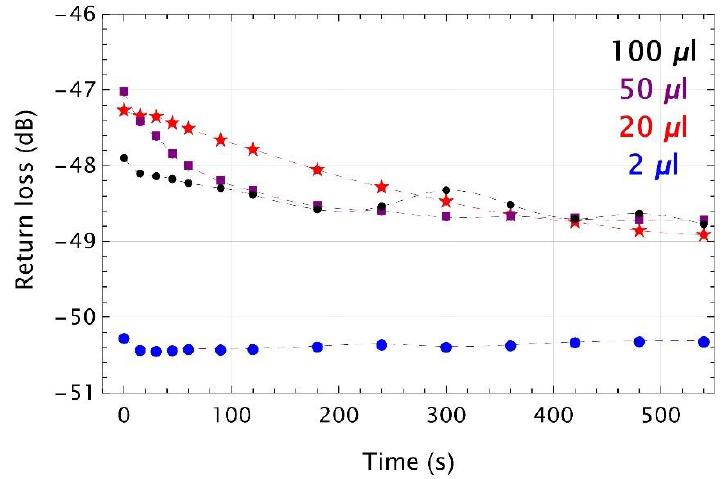
Figure 5. Time responses as return loss vs. time for MMF 105 without microtip with the presence of TMP in the glass vial of the volumes of: 2 µL (blue), 20 µL (red), 50 µL (purple), and 100 µL (black). Colored markers are experimental points, while the dashed lines are their cubic polynomial interpolations.